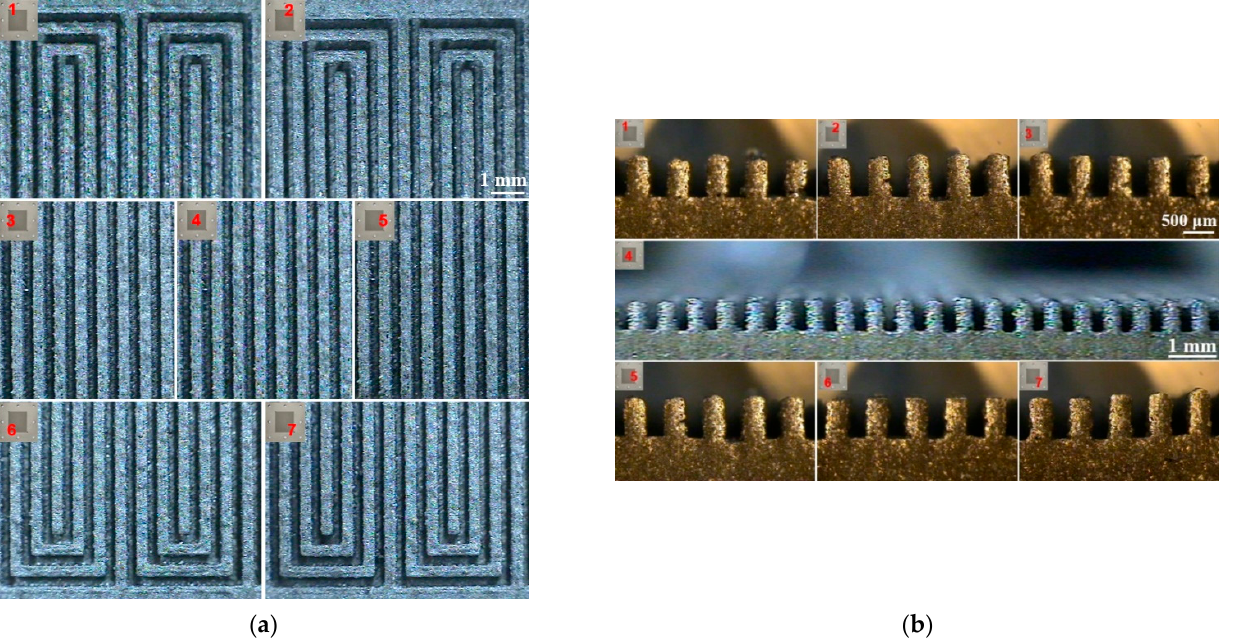
Figure 7. Digital microscope image of the flow field of the PBF-built SUS 316L BP: ( a ) Planar view; ( b ) Cross-sectional view.